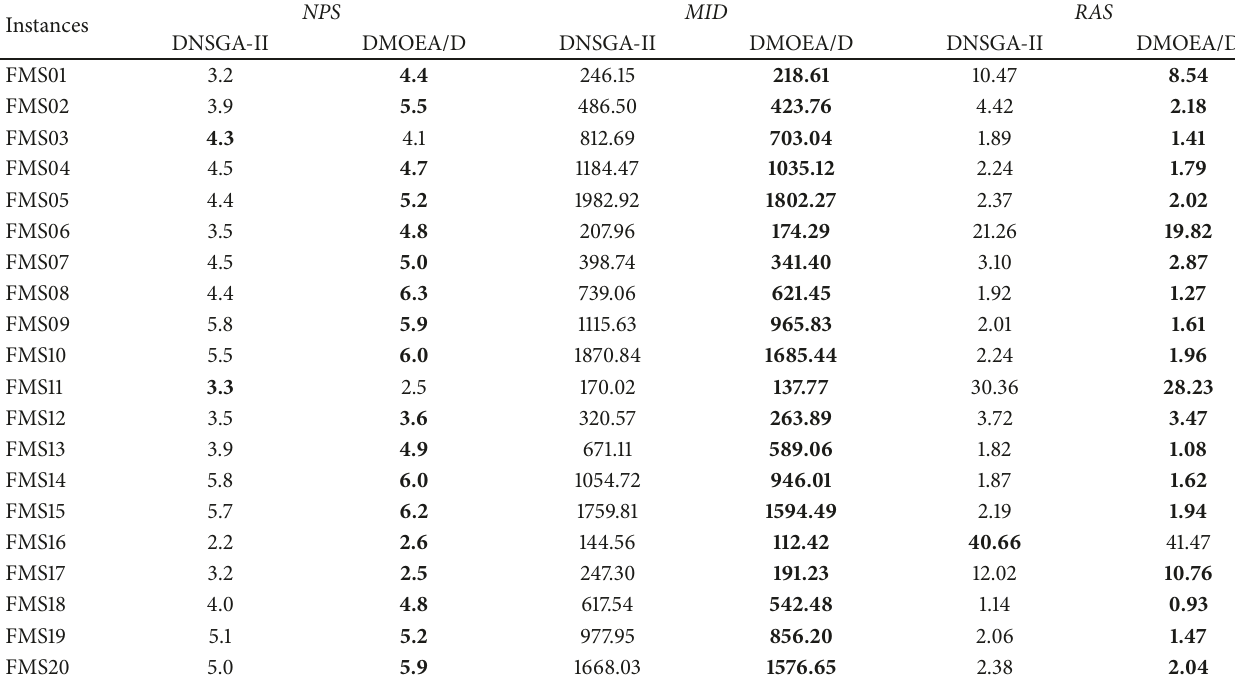
Table 4: Scheduling results of 3-objective problem (FMS01-FMS20).